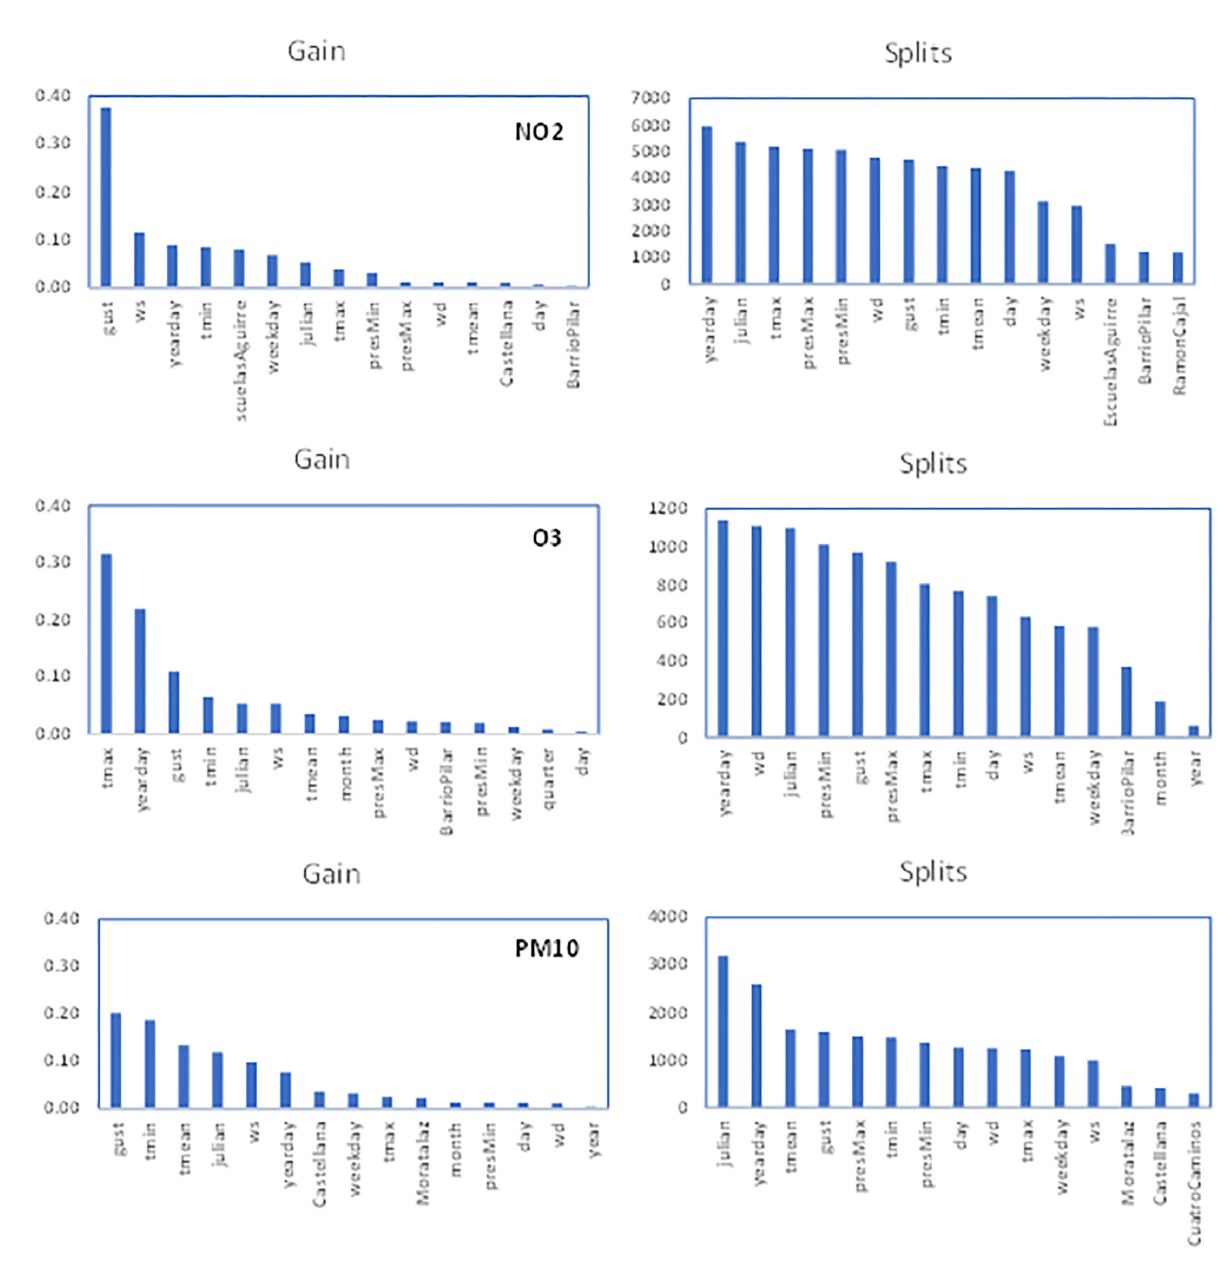
models through different training sets. Furthermore, Gong et al. (2022) obtained an r 2 of 0.66 for O 3 using MLR and a more variable result for PM 2.5 . Therefore, they deduced that PM 2.5 is less affected by meteorology than O 3 . In terms of particulates, Grange et al. (2018) obtained an r 2 that ranged between 0.54 and 0.71 for PM 10 , whereas Qu et al. (2020) found an r 2 of 0.69 for PM 2.5 in the test set using a complex ensemble algorithm. The abovementioned results highlight the performance of more modern GBT